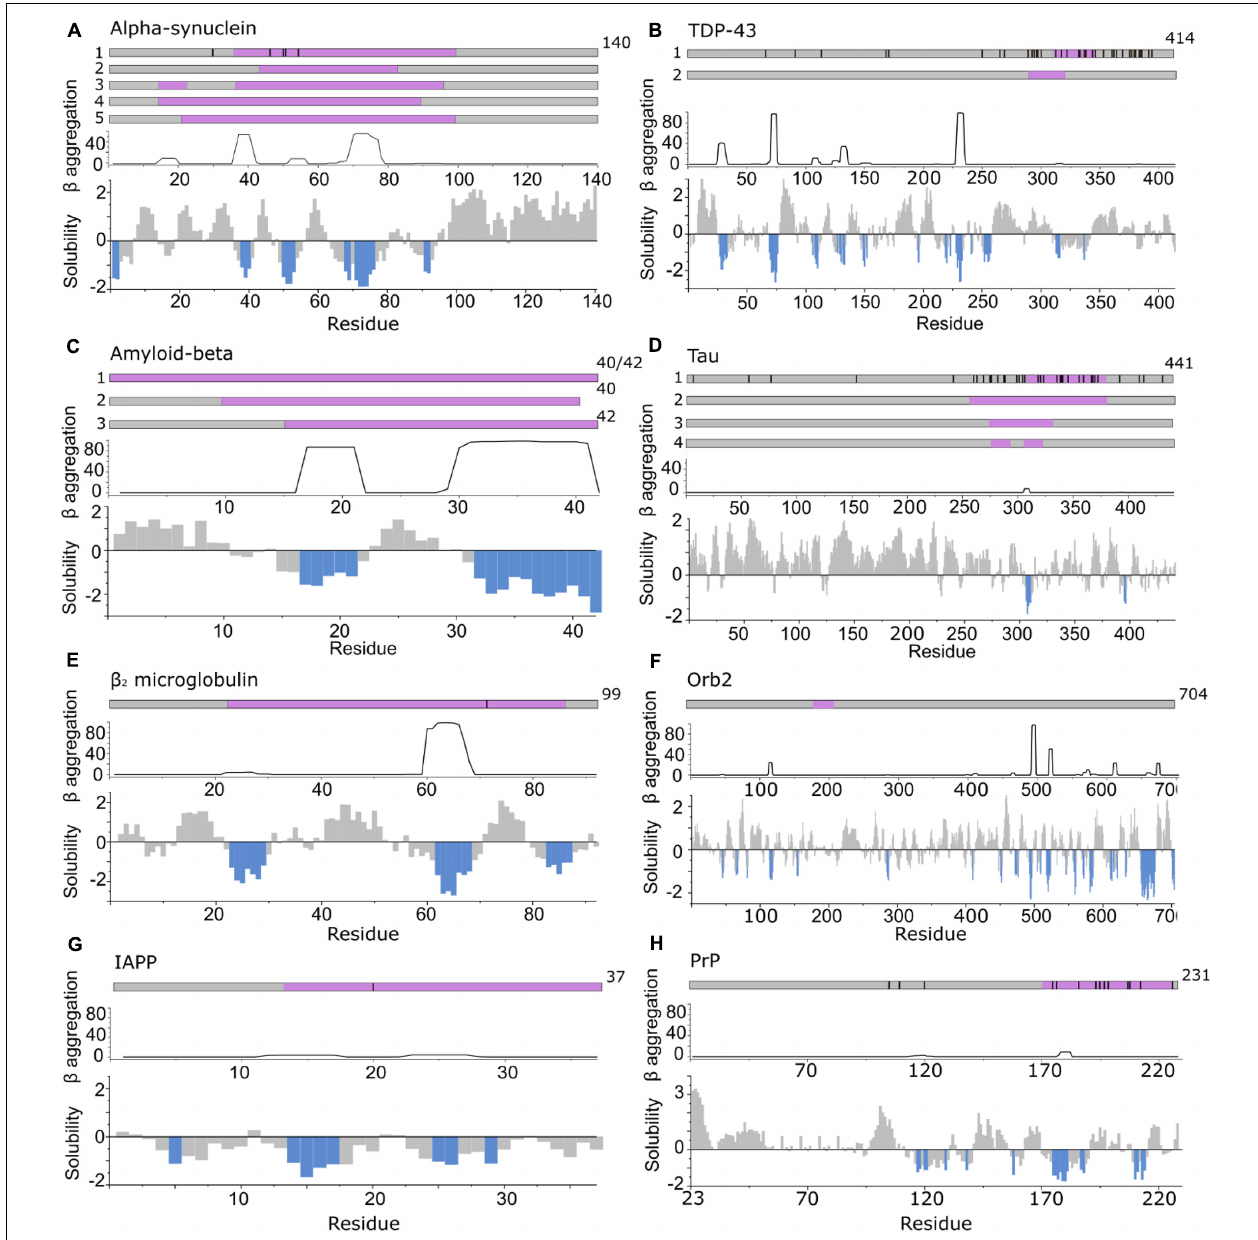
FIGURE 3 | APRs comprise only a small part of the amyloid core. Top in A–H: location of fibril cores of α Syn, TDP-43, A β , Tau, β 2 m, Orb2B, IAPP, and PrP defined by recent cryoEM or ssNMR fibril structures (purple). The positions of familial disease mutations are highlighted where appropriate as black lines. Bottom in A–H: regions with low solubility predicted by CamSol (below –1 is aggregation promoting highlighted in blue) (Sormanni et al., 2015) and the β -aggregation potential of each sequence predicted using TANGO (Fernandez-Escamilla et al., 2004). (A) α Syn including polymorph 1a (1) (Guerrero-Ferreira et al., 2018; Li B. et al., 2018; Li Y. et al., 2018) (core residues 37–99), 1b (2) (Li B. et al., 2018) (core residues 43–83), 2a and b (3) (Guerrero-Ferreira et al., 2019) (core residues 14–24, 36–96) and the MSA ex vivo structures including residues 14–94 (for PF-IA and PF-IIA) (4) or residues 21–99 (for PF-IB and PF-IIB) (5) in the fibril core (Schweighauser et al., 2020). (B) TDP-43 cryoEM structure solved from C-terminal segments forming a dagger shaped core (1) (residues 312–346) or R-shaped core (2) (residues 288–319) (Cao et al., 2019). (C) A β structures solved (1) for A β 42 (Gremer et al., 2017) and A β 40 in which all residues comprise the core (Lu et al., 2013; Kollmer et al., 2019) (2) fibrils in which the core is formed by residues 10–40 for A β 40 (including polymorphs 2A and 3Q) (Petkova et al., 2002; Paravastu et al., 2008) and (3) for A β 42 (core formed by residues 15–42) (Colvin et al., 2016; Wälti et al., 2016). (D) Tau fibril structures PHF and SF from Alzheimer disease patients (1) (Fitzpatrick et al., 2017) (core residues 306–378), NPF and WPF from Pick’s Disease (2) (Falcon et al., 2018) (core residues 254–378) and heparin induced structures 4R-s and 3R formed in vitro (3) (core residues 272–330) and 4R-t and 4R-j (4) (core residues 274–292, 304–321, respectively) (Zhang et al., 2019). (E) The β 2 m fibril core involves residues 22–85 (Iadanza et al., 2018b; Gallardo et al., 2020a). (F) The Orb2B fibril core consists of residues 176–206 (Hervas et al., 2020). (G) Human IAPP forms fibrils with residues 13–37 (Röder et al., 2020), 14–37 (Cao et al., 2020), or 13–37 (Gallardo et al., 2020a), with its early onset S20G variant adopting fibrils with two- and three filaments involving residues 15–37 in the core (Gallardo et al., 2020a). (H) PrP fibrils form fibril core with residues 170–229 revealed using cryoEM (Wang et al., 2020).